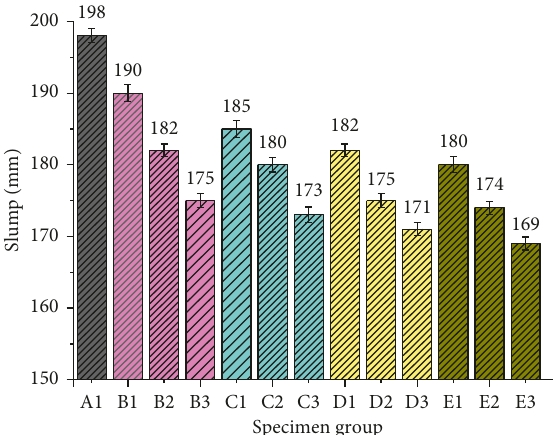
Figure 3: Slump of mixture with different contents and milling durations. Figure 4. UFSS could accelerate the development of com- pressive strength at the early age of concrete. For E3 with 50% of UFSS60, the 3-day strength reached 60.1% of that of 28 days, while the values of B3, C3 and, D3 were found to be 48.1%, 56%, and 58.7%, respectively. For 50%, the ratios of 7 and 28 days strength of original slag, UFSS20, UFSS40, and UFSS60 were found to be 63.7%, 65.7%, 69.3%, and 74.2%, respectively.